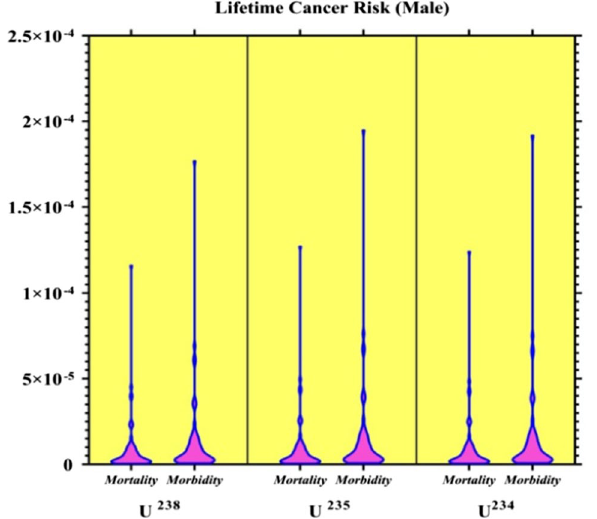
Fig. 27 Distribution of life time cancer risk (females) in the samples